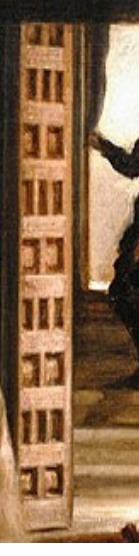
Figure 9. Las Meninas , door detail (See Figure 1). (Alas, I am more mismanaged window than turned canvas. No mystery, just